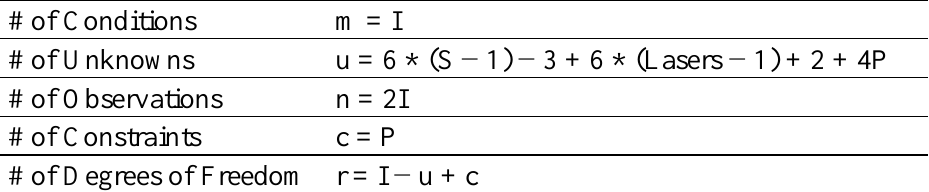
Table 2. Summary of self-calibration adjustment